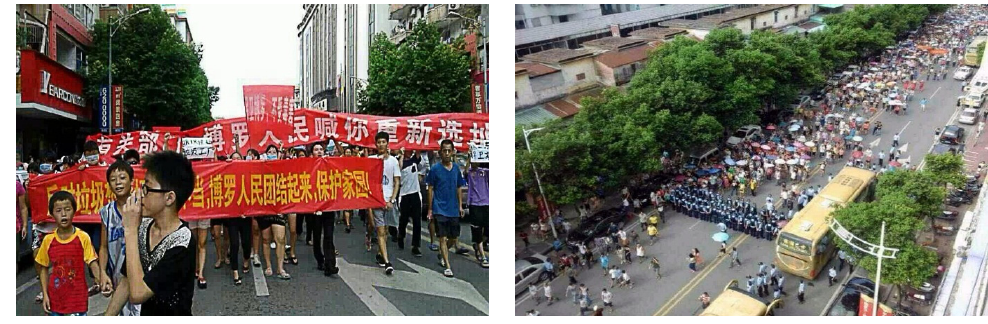
Figure 5. Protests against WTE incineration in China (photos source: [49]).